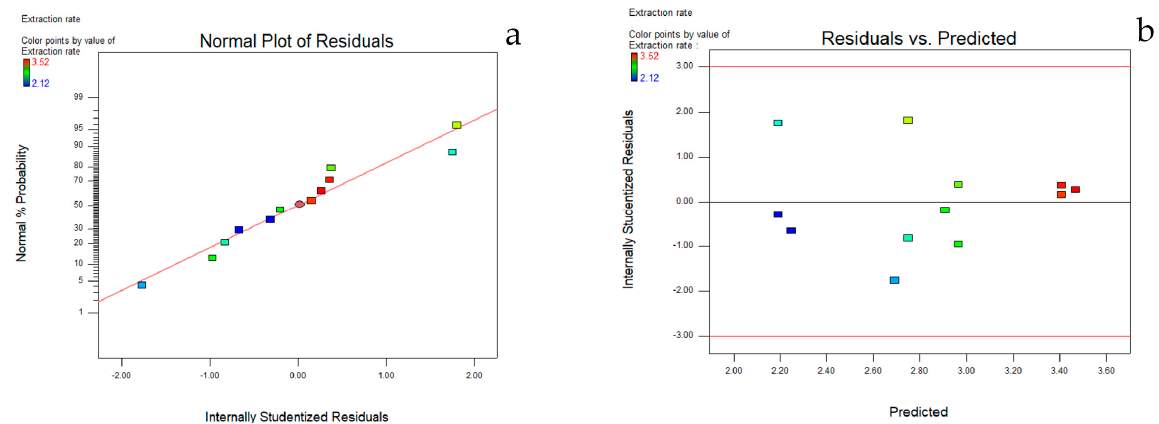
Figure 2. Plots of normal probability of internally studentized residuals and internally studentized residuals vs. predicted response. ( a ) The normal probability plot of the residuals. ( b ) The plots of residuals vs. the predicted responses.